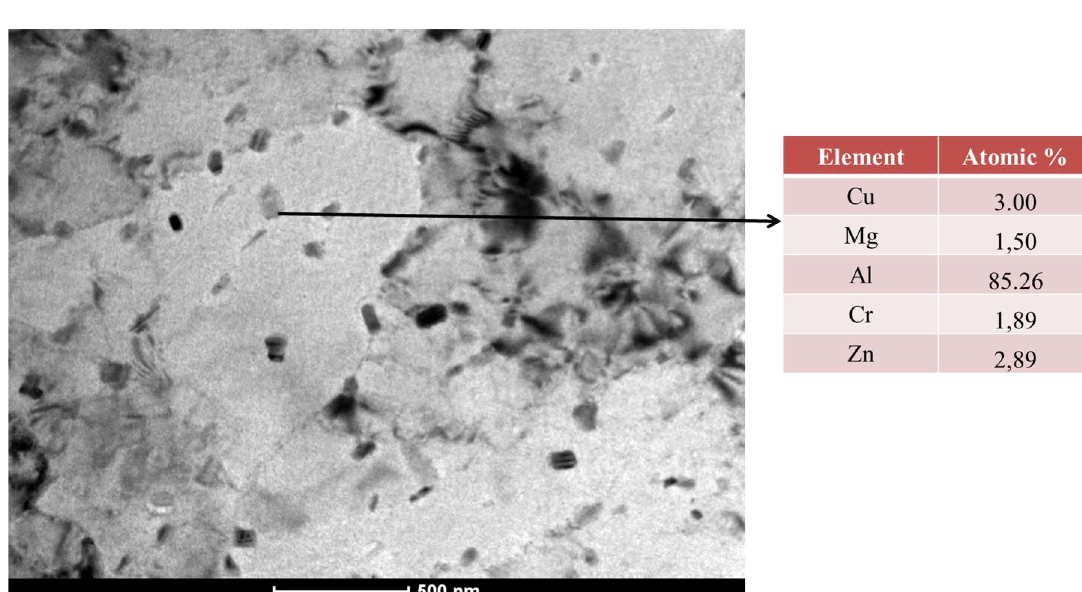
Figure 3. TEM micrograph of AA 7075 (T6). The observed particles are insoluble dispersoids and they are constituted of